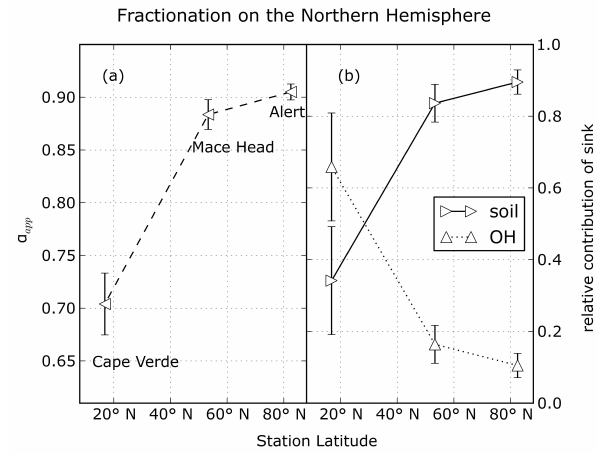
Fig. 7. (a) Apparent fractionation factors for the NH, calculated from a least-squares fit to a Rayleigh plot, plotted as a function of station latitude. (b) Relative contributions of uptake by soils and atmospheric oxidation by OH to the total sinks, calculated from the apparent fractionation factors and the values for the fractionation processes used by Rhee et al. (2006b). Error bars indicate one stan- dard